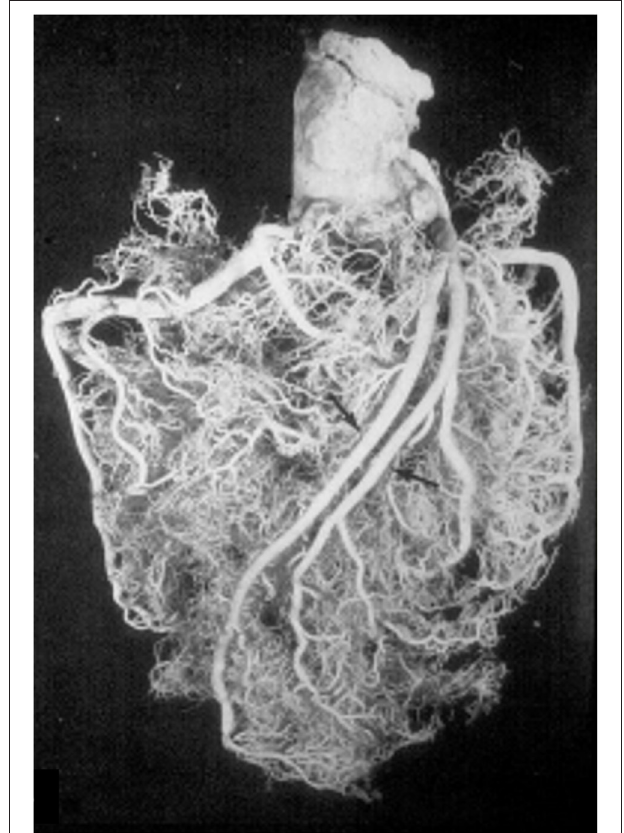
FIGURE 7 | A double left anterior descending coronary artery (arrows). From Baroldi and Scomazzoni ( 3).